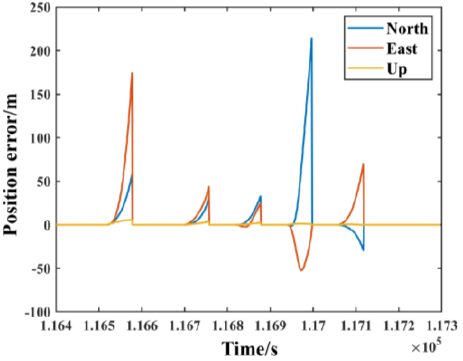
Figure 12. Positioning errors of classical GNSS/INS integration algorithm during GNSS outages in offshore experiment.